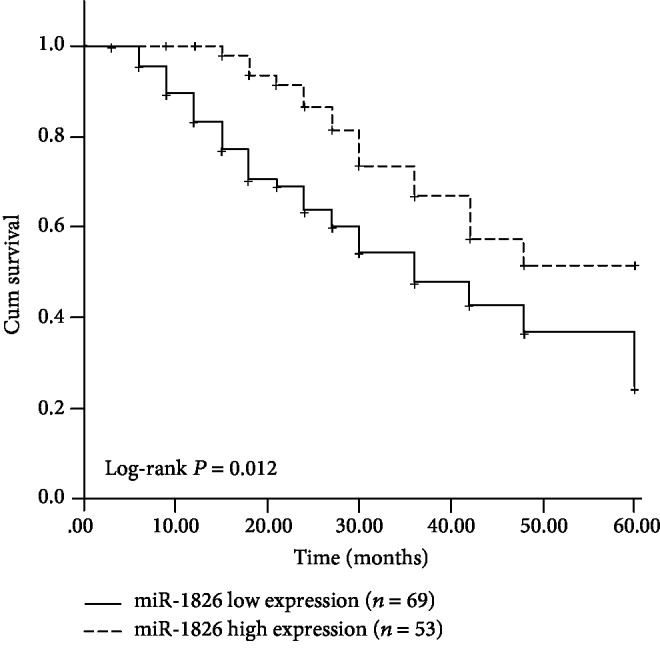
Kaplan-Meier survival curves constructed based on the survival information of OS patients. Low miR-1826 levels were associated with a shorter survival time in OS patients. Log-rank P = 0.012.